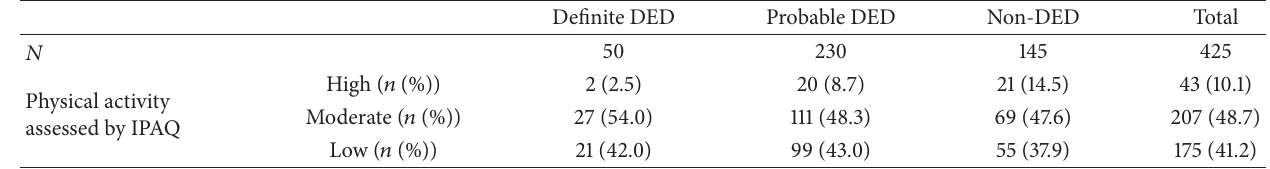
Table 2: Comparison of physical activity according to dry eye disease criteria. Definite DED Probable DED Non-DED Total